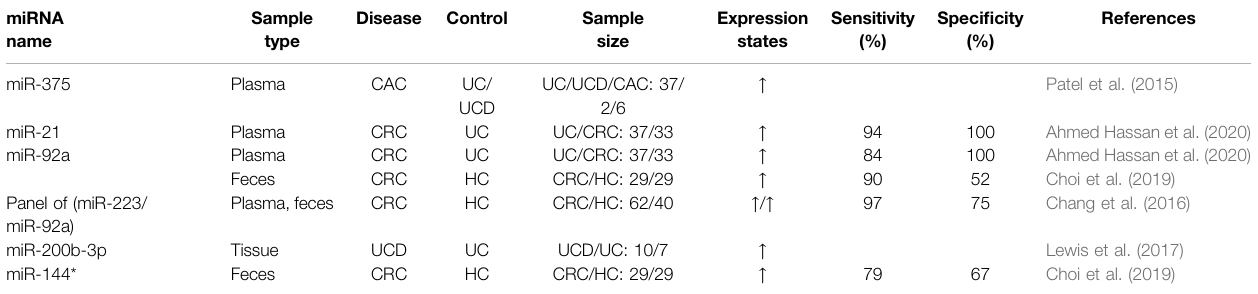
TABLE 4 | miRNA levels of CAC or CRC patients in different studies. miRNA